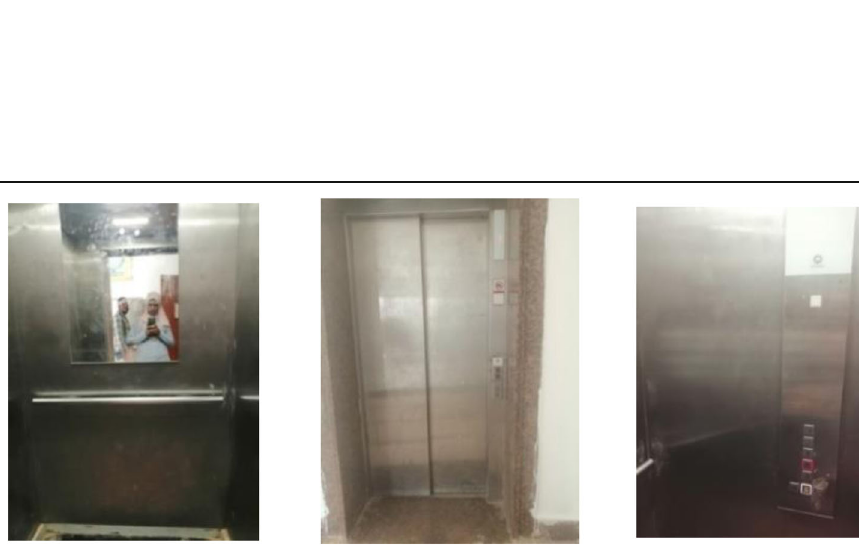
Fig. 12 The building has one elevator (2020)